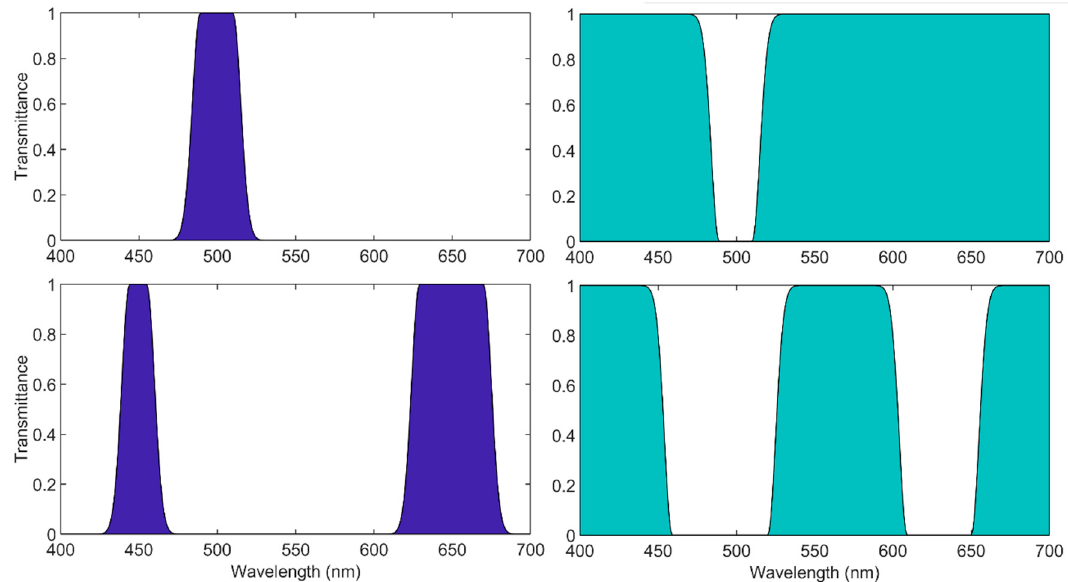
Figure 3. Top: left: spectral transmittances of single band-pass filter. Right: spectral transmittances of single notch filter. Both centered on 500 nm with 30 nm FWHM. Bottom: Left: example of a double band-pass filter. Right: example of double-notch filter.